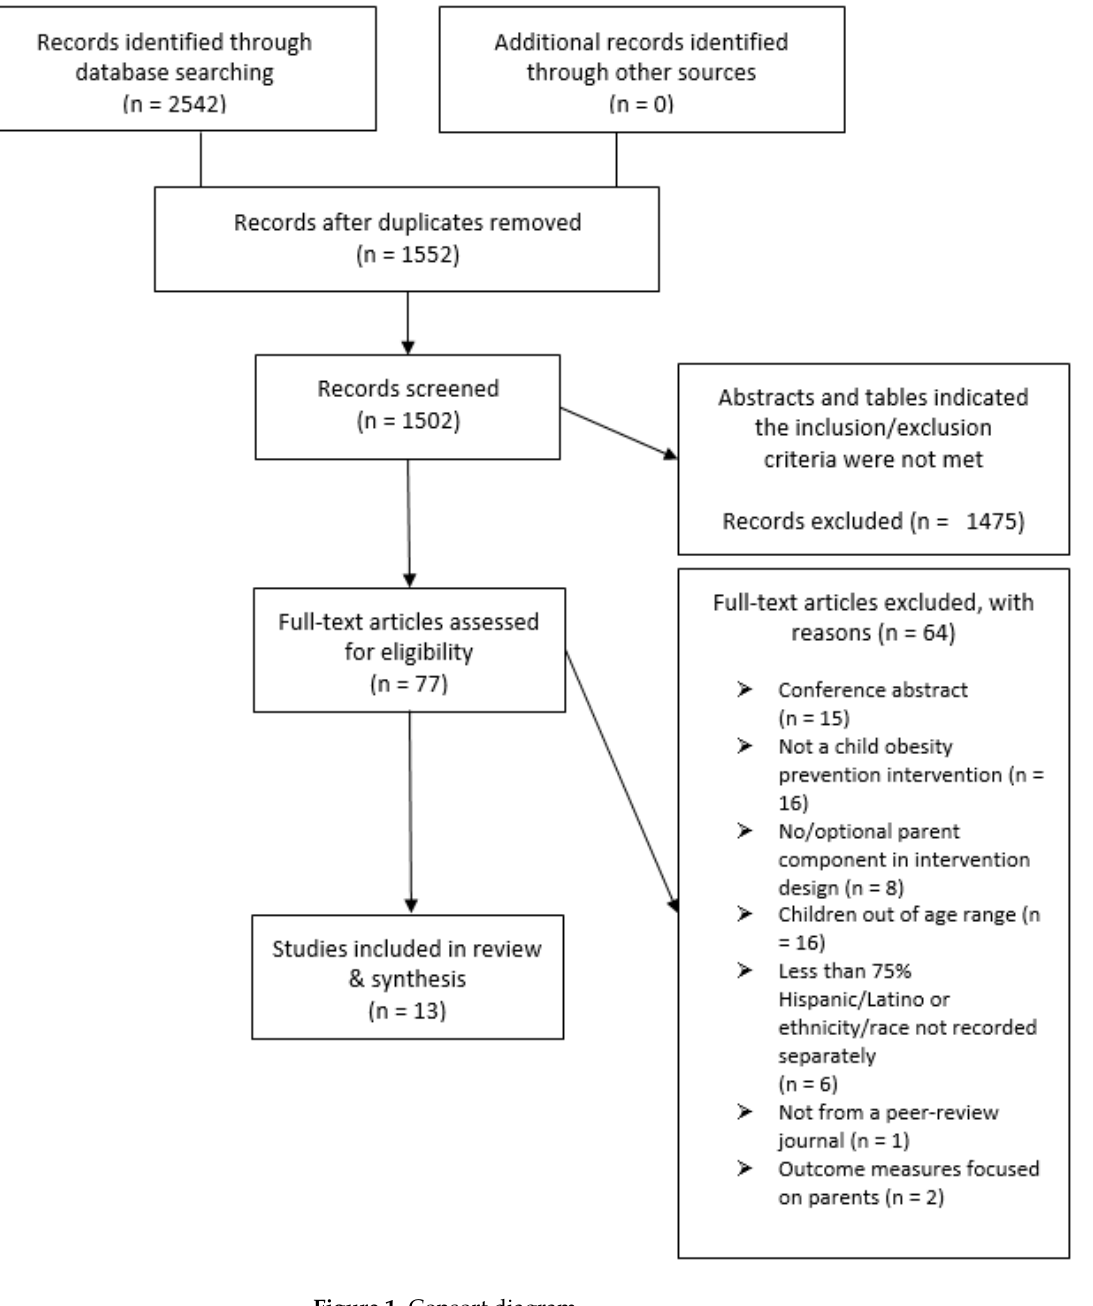
Figure 1. Consort diagram.